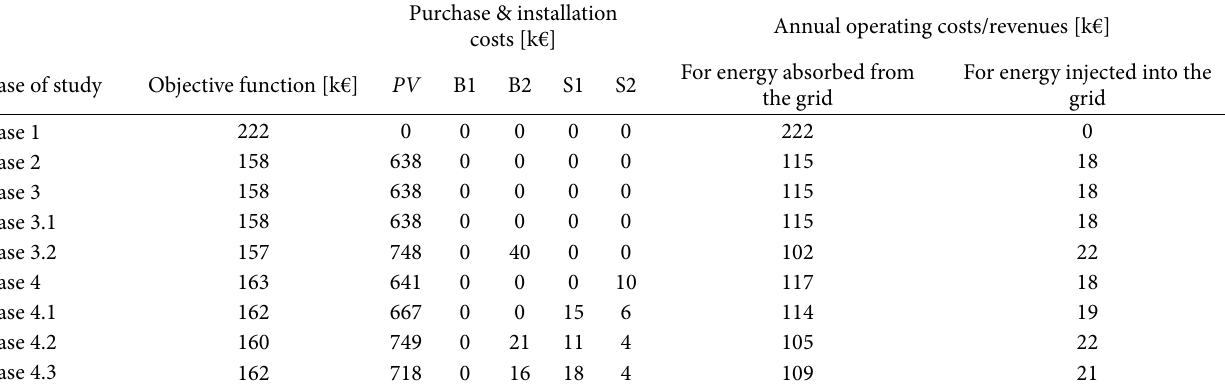
Table 2: Optimal economic values.